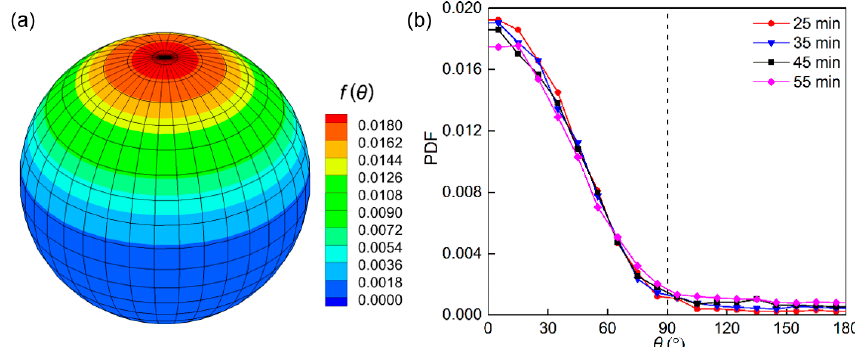
Figure 8. Distribution of f ( θ ), ( a ) spatial distribution of f ( θ ), and ( b ) f ( θ ) at different time. Water 2018 , 10 , x FOR PEER REVIEW